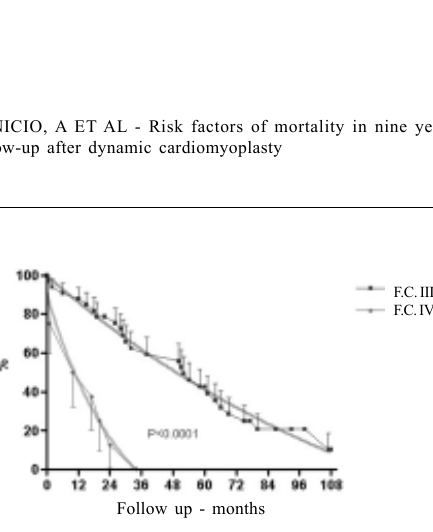
Fig. 3 - Actuarial survival curve (Kaplan-Meier) after dynamic cardiomyoplasty, according to the pre-operative functional class (FC). P-value was calculated by the log-rank test.